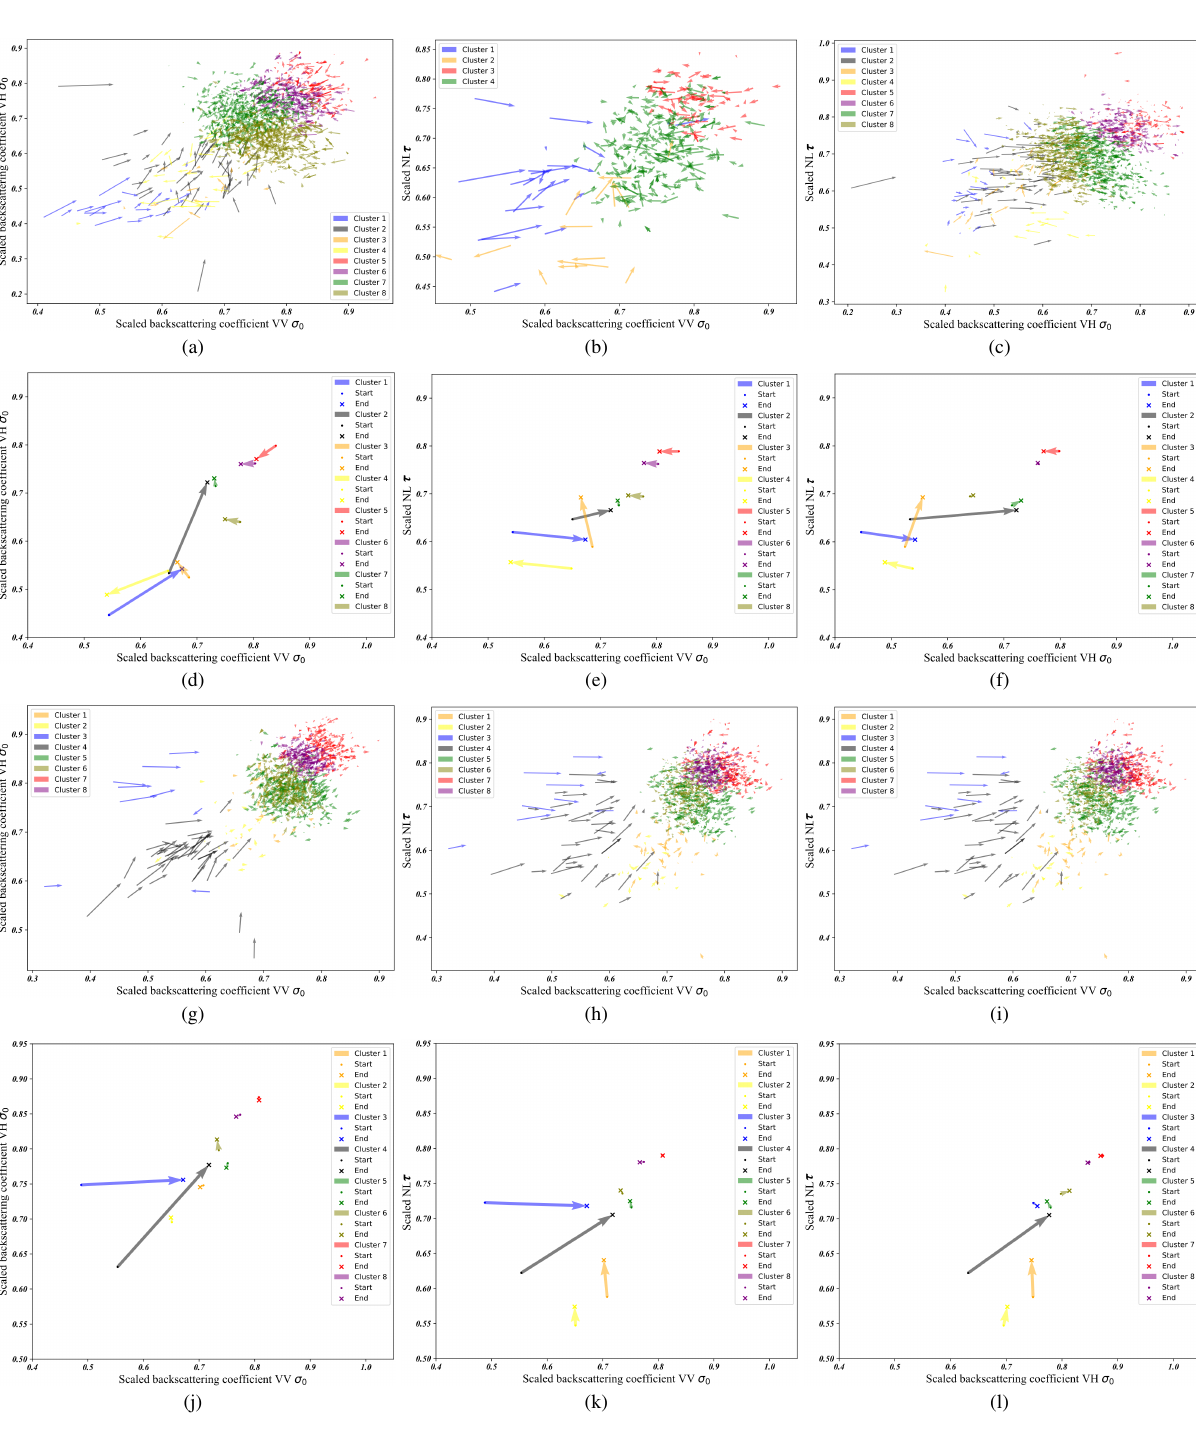
Figure 5. Vector analysis for the 8 component clusters in the Jingjinji (a-f) and Yangtze River Delta (g-l) megalopolis: (a-c and g-i) using a subset of points; (d-f and j-l) using only the cluster